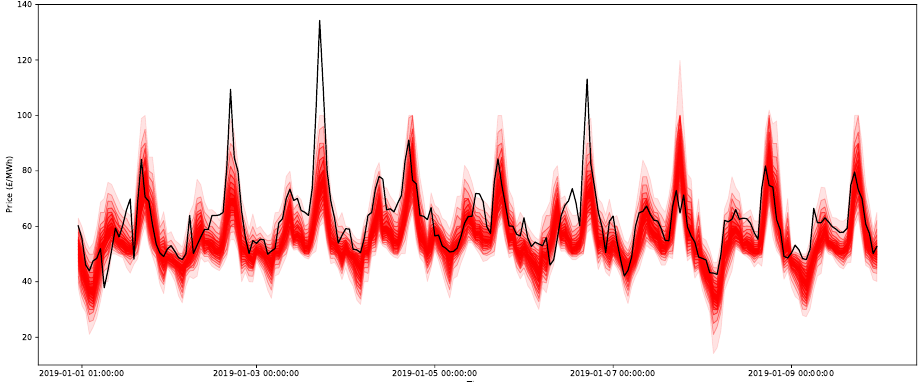
Figure 18. Sample of the X-model’s forecast for the first nine days of the test periods. The different confidence bounds are given different shades, with the darkest representing the prediction interval for the middle ten percent. The actual prices are given by the black